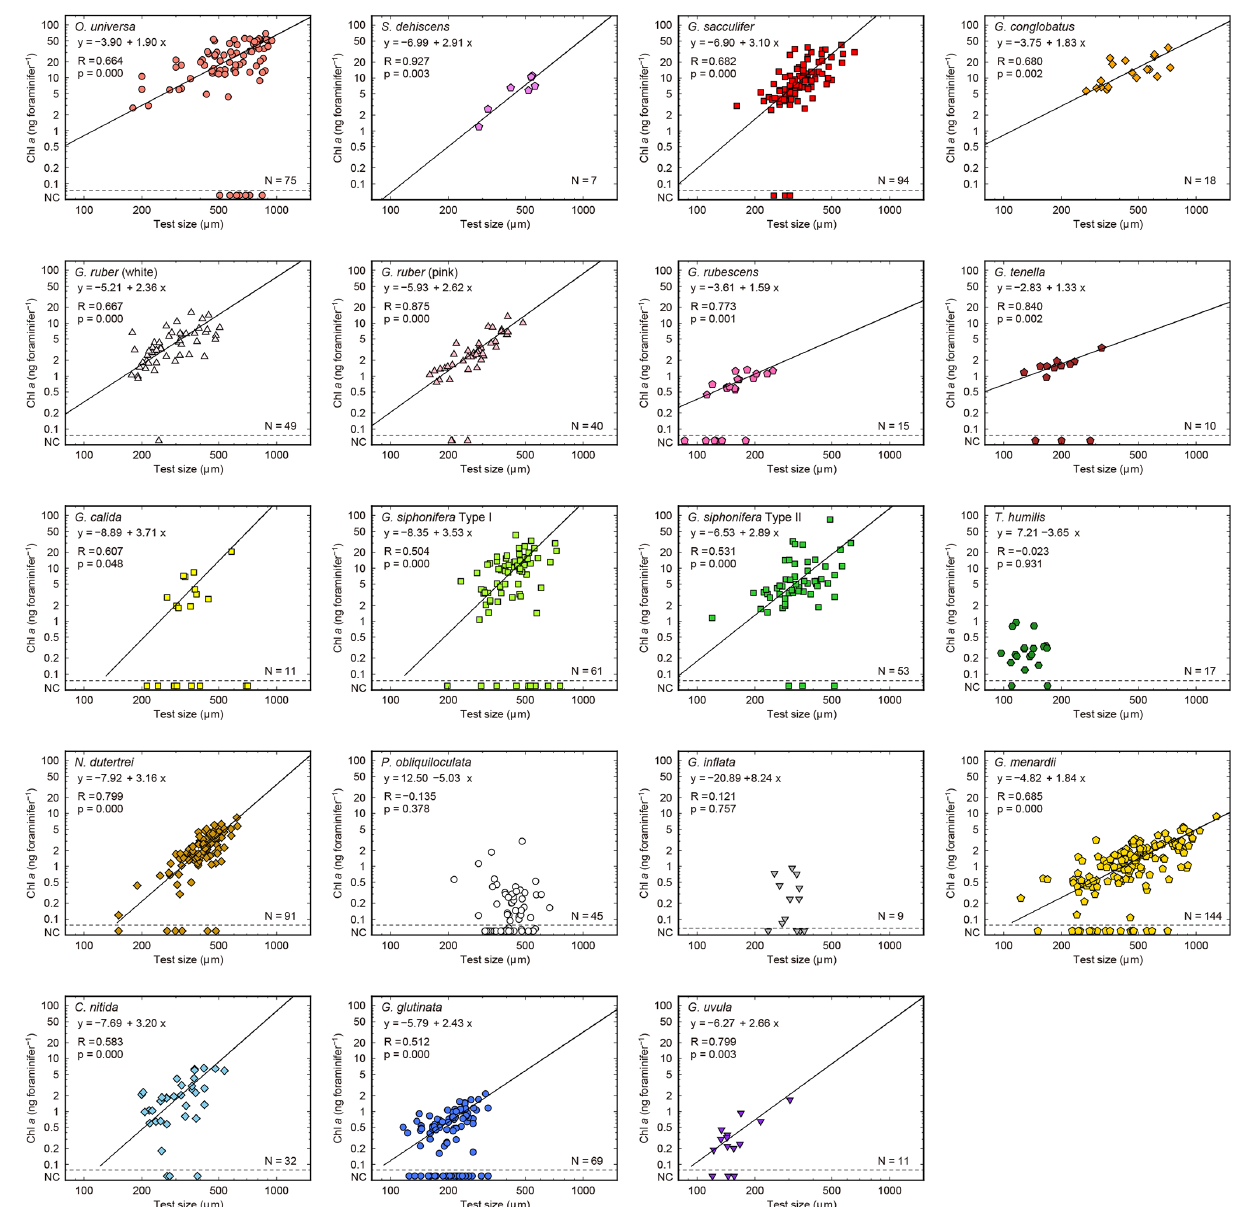
Figure 6. Relationships between test size and Chl a content for each species. Lines represent reduced major axis regression ( y represents log(Chl a ), and x represents the log(test size)). Specimens with no chlorophyll and non-functional chlorophyll (NC) are plotted at the bottom of each panel to show their test size information (these data are not used for the regression analysis). R: Pearson’s correlation coefficient; p : p value; N : number of specimens with functional chlorophyll (i.e., with symbionts). For O. universa , specimens smaller than 400µm are a pre-spherical trochospired test diameter, and those larger than 400µm are a sphere diameter (see Table